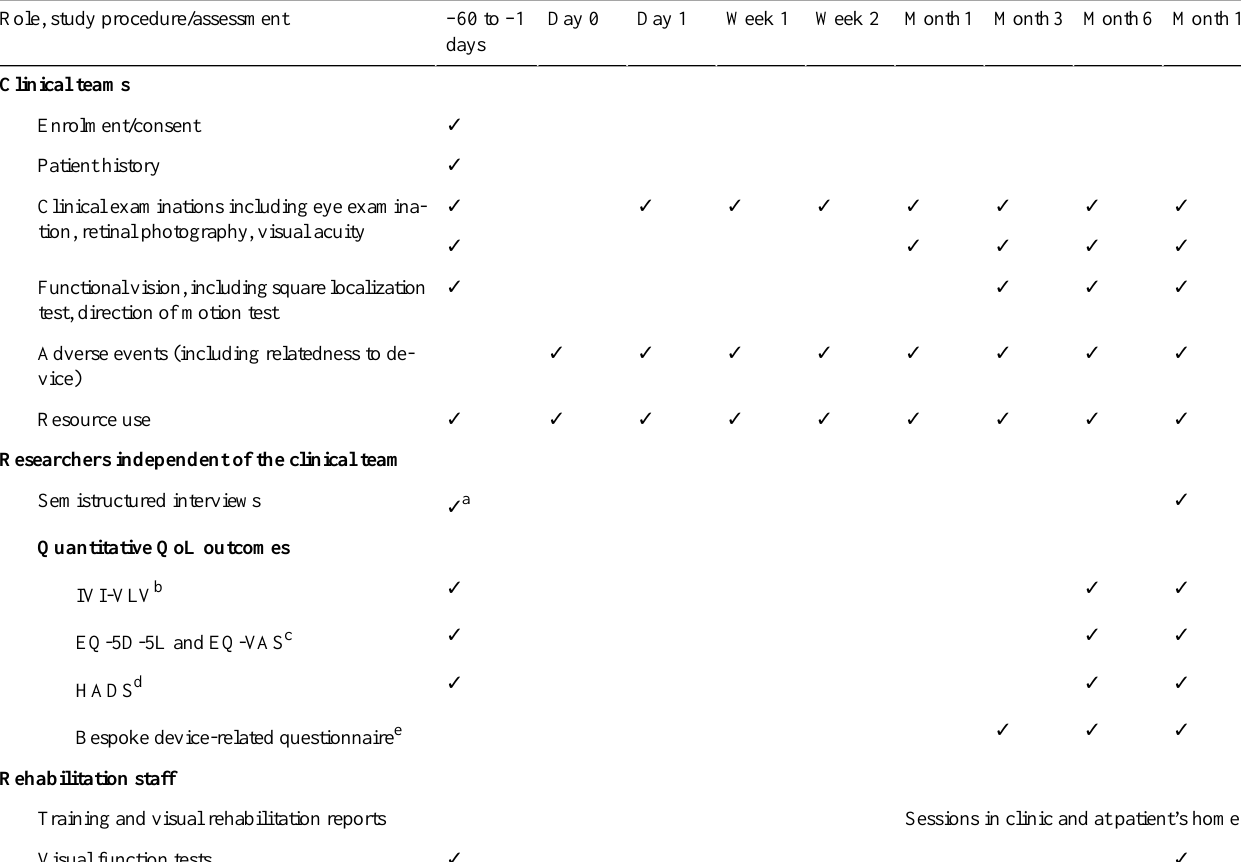
Table 1. Schedule of the study procedures and